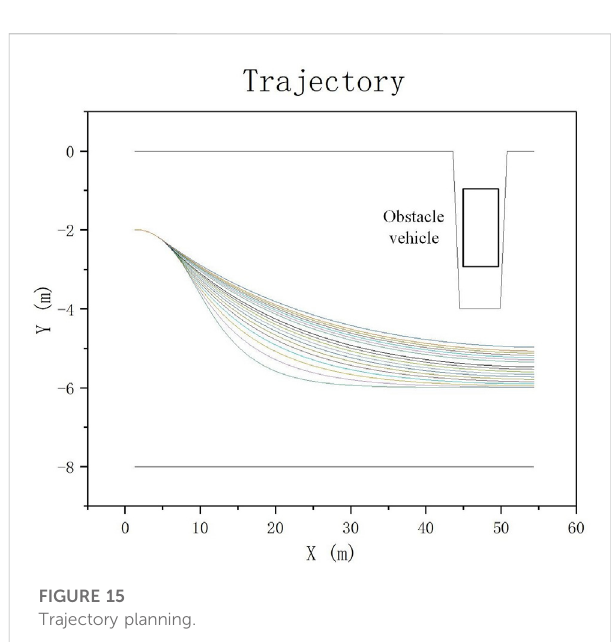
FIGURE 14 Change of tyre braking force with time.